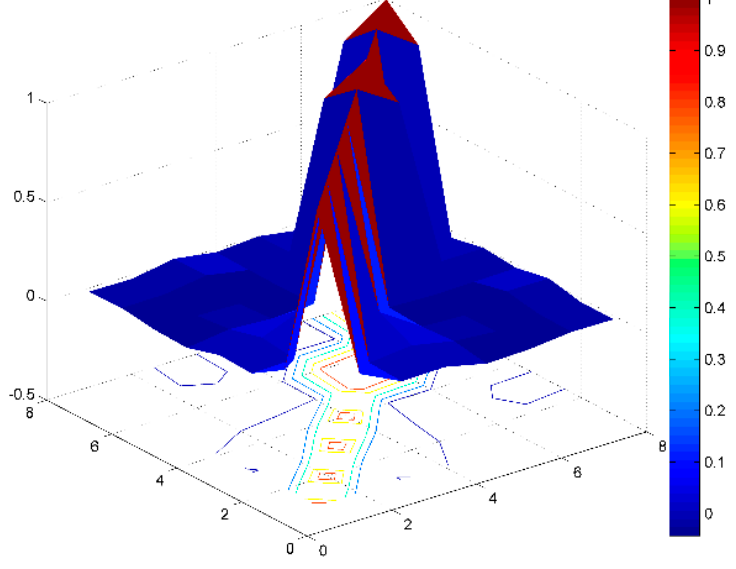
Appl. Sci. 2019 , 9 , x FOR PEER REVIEW Figure 13. Normalized inter-covariance function of the 7th and 8th vibration accelerations vectors. Figure 13. Normalized inter-covariance function of the 7th and 8th vibration accelerations vectors. Figure 13. Normalized inter-covariance function of the 7th and 8th vibration accelerations vectors.